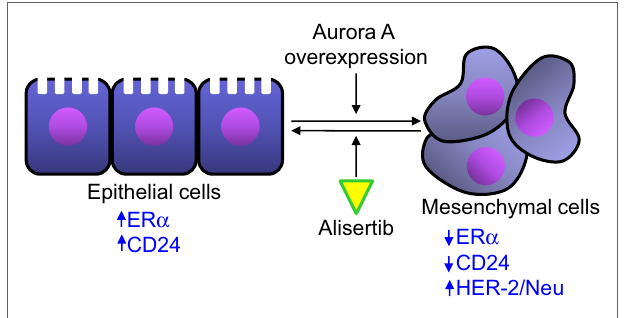
FiGURe 3 | Aurora A activity affects epithelial to mesenchymal transition in breast cancer cells . Aurora A overexpression leads to the transition of breast cancer cell from an epithelial phenotype to a mesenchymal phenotype, leading to decreased ER α and CD24 expression and HER-2/Neu overexpression. Alisertib counteracts the effects of Aurora A overexpression leading to an epithelial to mesenchymal transition